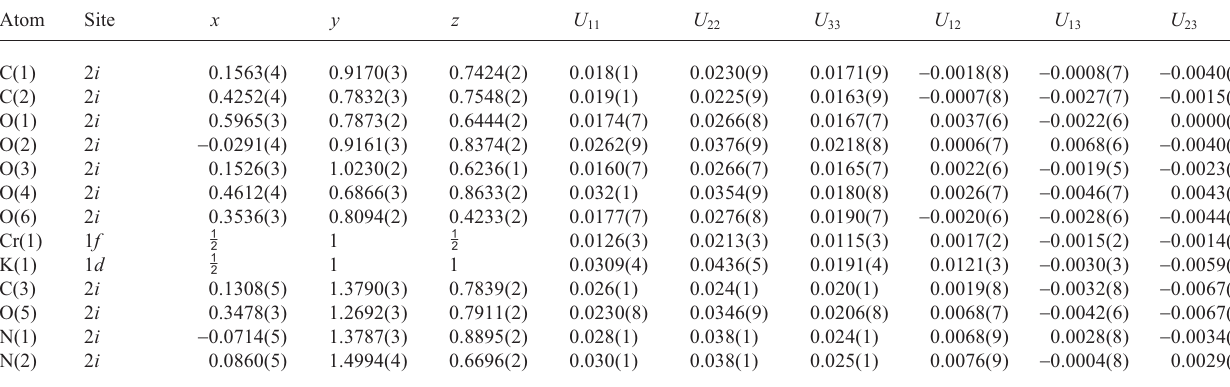
Table 3. Atomic coordinates and displacement parameters (in Å 2 )